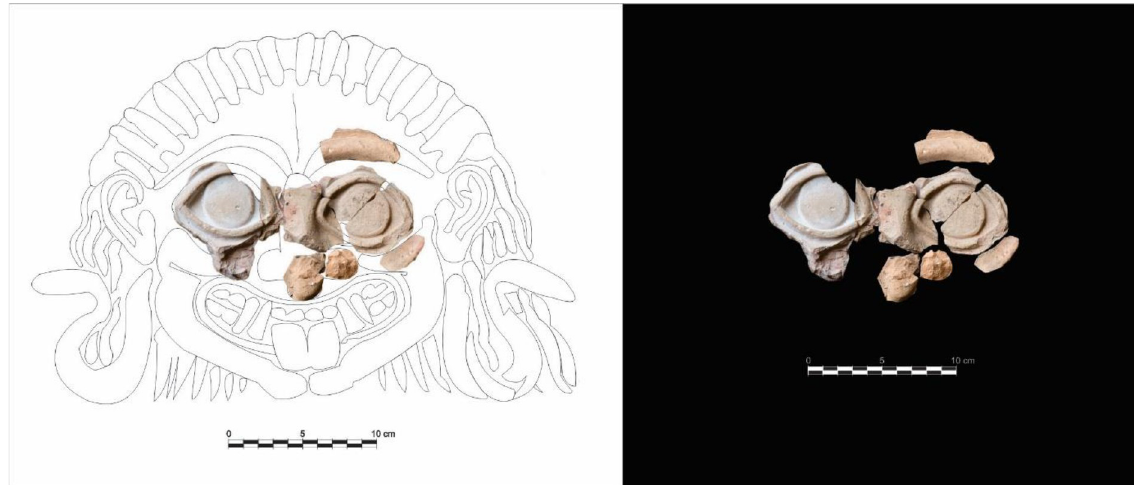
Fig 3. Fragments recovered from Gorham’s Cave (right) with a reconstruction of the complete Gorgoneion. See also S1 File. Specimen IDs: GOR/’98/B3/52a; GOR/’98/B3/52b; GOR/’98/B3/52c; GOR/’98/B3/52d; GOR/’98/B3/52e; GOR/’98/B3/52f; GOR/’98/B3/52g; GOR/’98/ B3/52h; GORHAM’S C 1958 GA7(a); GORHAM’S C 1958 GA7(b); GOR99/alpha2/N I/140; GOR99/alpha alpha2/N I/36. Stored at The Gibraltar National Museum, Gibraltar. All necessary permits were obtained for the described study, which complied with all relevant